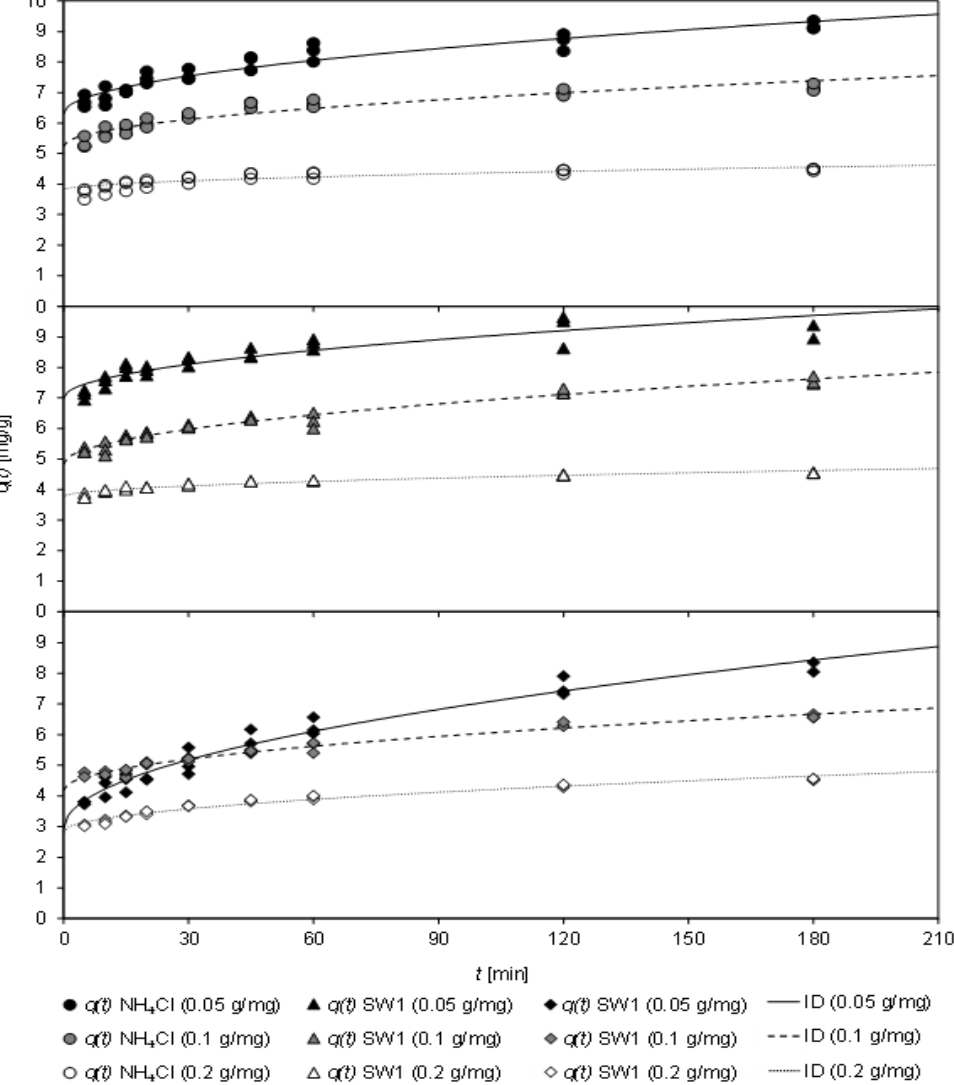
Figure 5. Loading q ( t ) of CCP 20 as a function of the contact time t after different specific sorbent ratios (0.05–0.2 g CLI /mg NH4-N ) aligned with the ID model ( T = 295 K; NH4Cl solution: c 0 = 1000 mg/L NH4-N; initial pH 5.3; final pH 6.3–7.0; SW1: c 0 = 967 mg/L NH4-N; initial pH 7.6; final pH 7.5–8.5; SW2: c 0 = 718–913 mg/L NH4-N; initial pH 7.6; final pH 7.7–8.2).